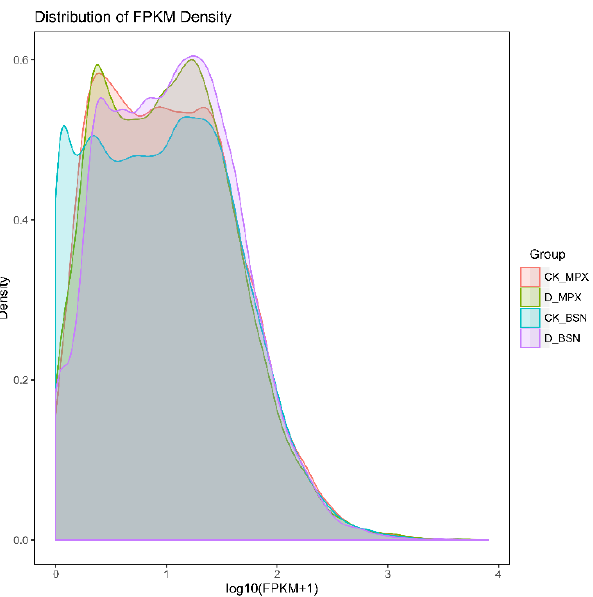
Figure 2. Gene FPKM density under 4 test conditions. Transcript abundance indicates the level of gene expression. Overlapped parts indicate similar gene expression levels, while non-overlapped parts indicate differences in gene expression levels.